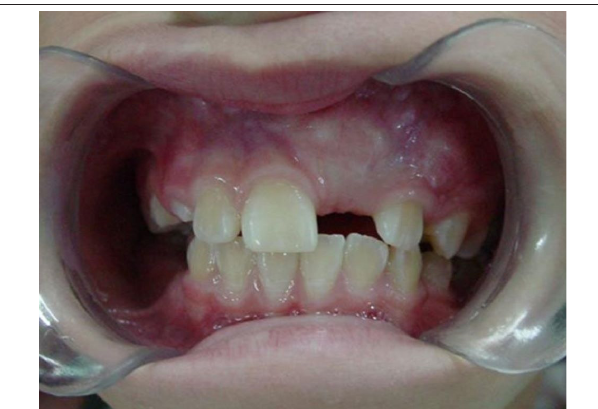
FIGURA 1 – Exame intraoral